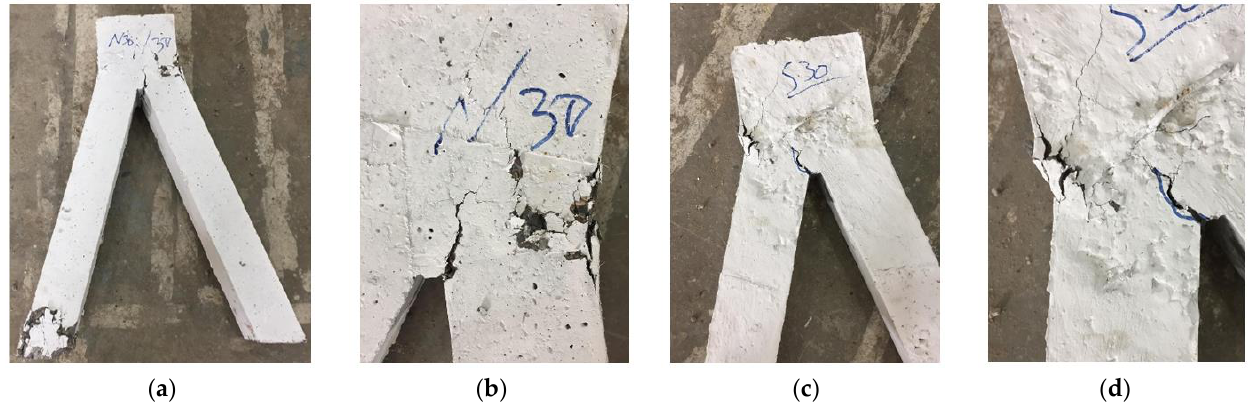
Figure 9. V-shaped columns with 30° angle ( a ) NRC-30, ( b ) NRC-30 failure zone, ( c ) FRC-30, and ( d ) FRC-30 failure zone.